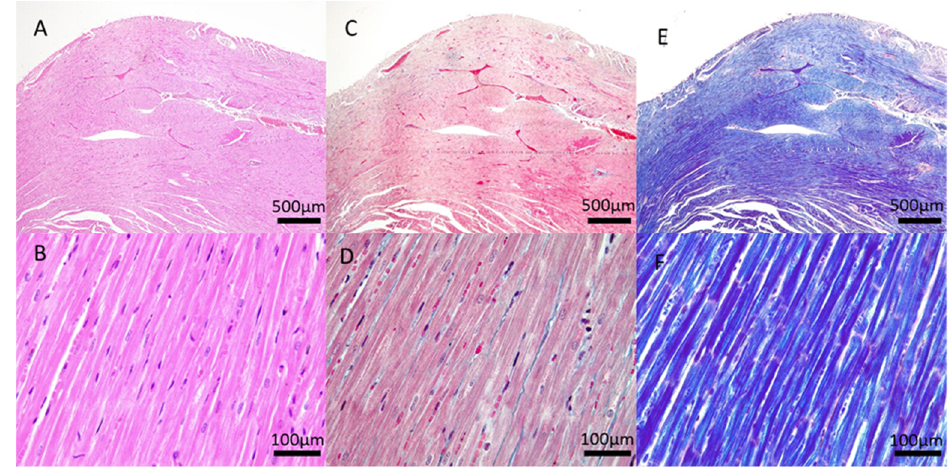
Figure 2. Histological photomicrographs of the cardiac tissue of rats in the control group show normal patterns of staining ( A ) HE—500 µ m, ( B ) HE—100 µ m, ( C ) Masson’s trichrome, ( D ) Masson’s trichrome—100 µ m, ( E ) PTAH—500 µ m and ( F ) PTAH—100 µ m.